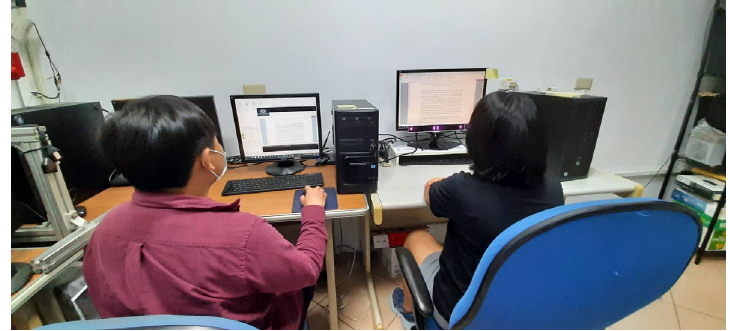
Figure 1. Apparatus and participant setting during the experiment.